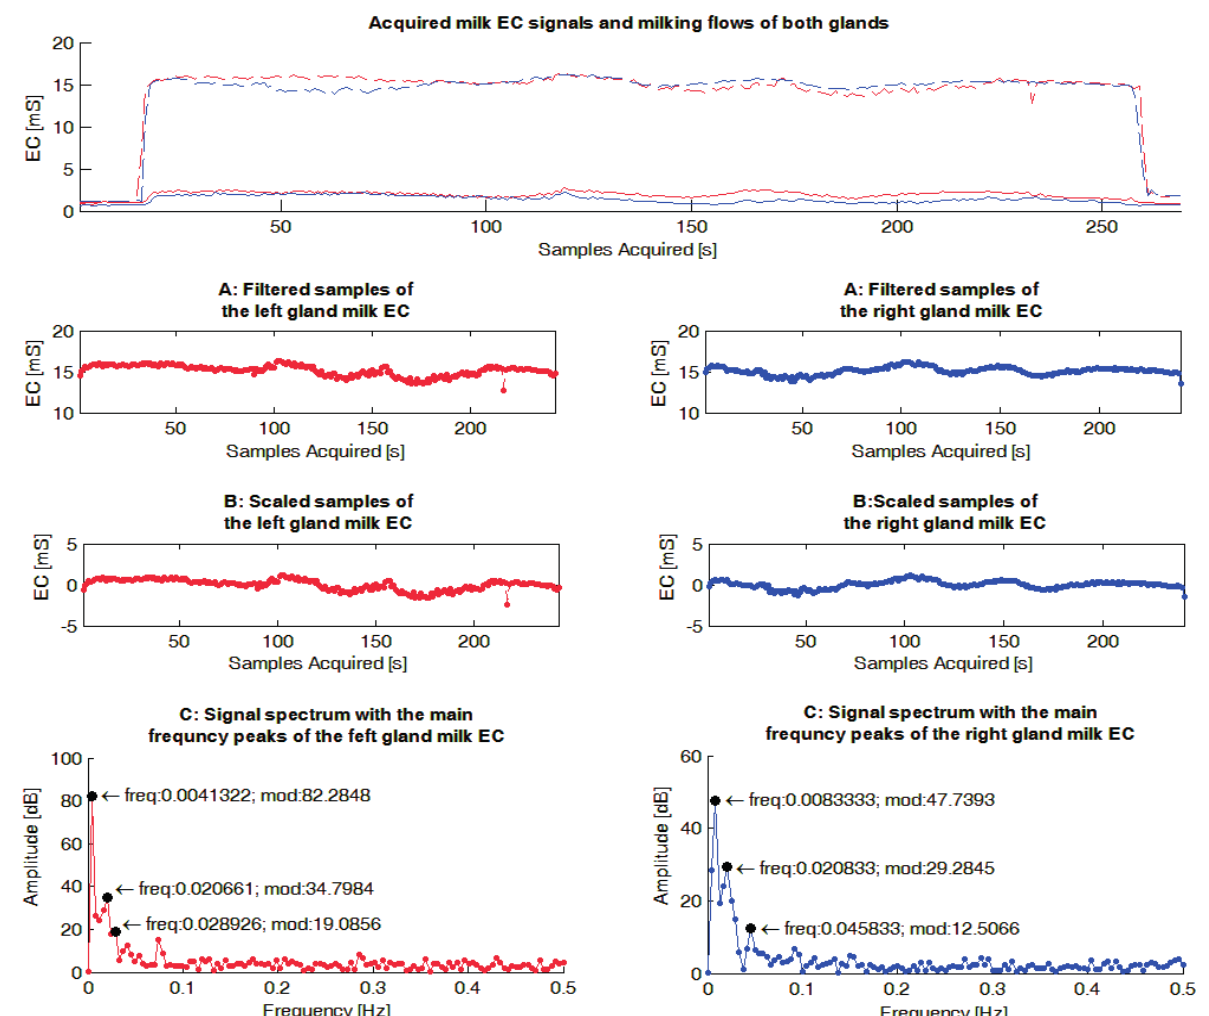
Figure 4. Example of gauges obtained from the milk electrical conductivity (EC) signals acquired within a milking. The graphs in red show data concerning the left gland while those in blue are reported data for the right gland. In the upper graph the measured EC signals of milk acquired during a milking from each gland are reported. In same graph the milk flows recorded by the experimental milking cluster used during the trial are also shown. The following graphs report on: (1) the sequences without the signal samples related to the start and the end of milking (“A: Filtered samples of gland milk EC”); (2) the sequences where the mean value of each sequence have been subtracted to each signal sample acquired (“B: Scaled samples of gland milk EC”); (3) the spectrums obtained, applying the Fast Fourier Transform to the previous sequences of signal samples, and the three main frequency peaks identified for each Fourier frequency spectrum (“C: Signal spectrum with the main frequency peaks of the gland milk